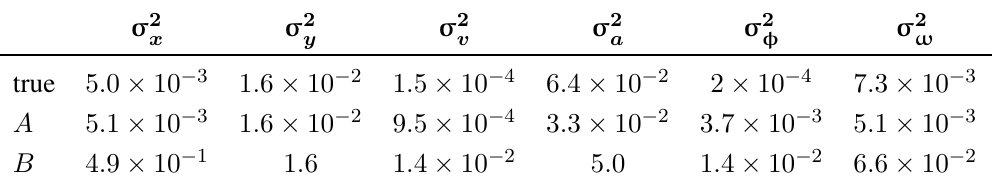
Table 3. True and estimated noise parameters of Dataset D 2